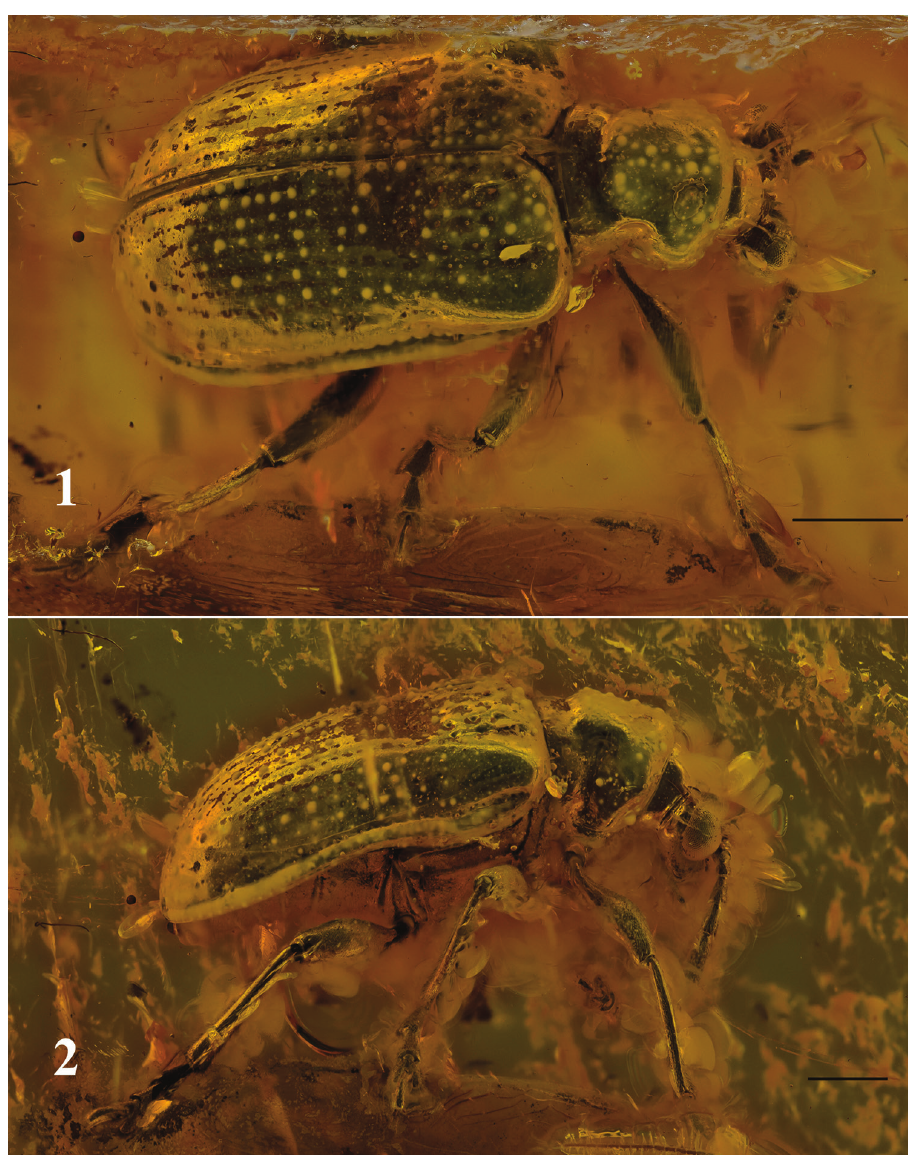
Figures 1–2. Lilioceris groehni sp. n., holotype: 1 habitus, dorsal view 2 habitus, lateral view. Scale bars: 1